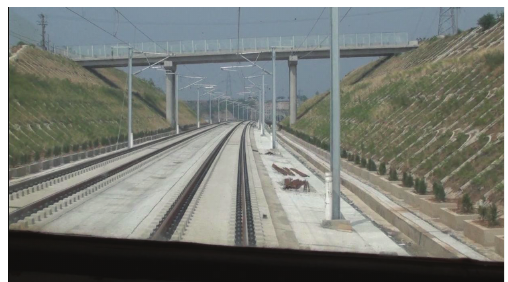
Figure 1: Viaduct scenario.